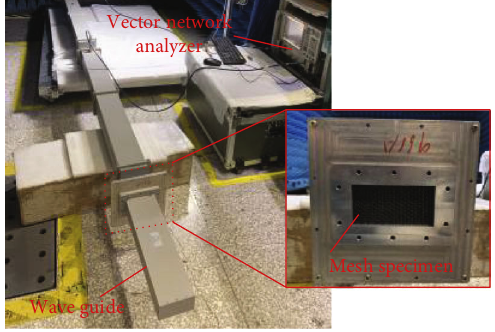
Figure 5: Electrical property test experiment.